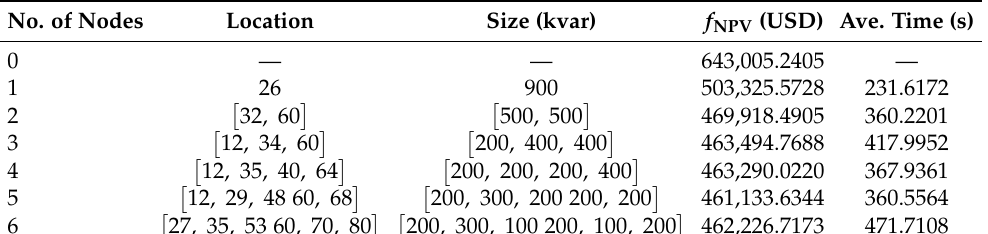
Table 10. Numerical results for the IEEE 85-bus regarding the optimal selection and location of fixed-step capacitor banks.